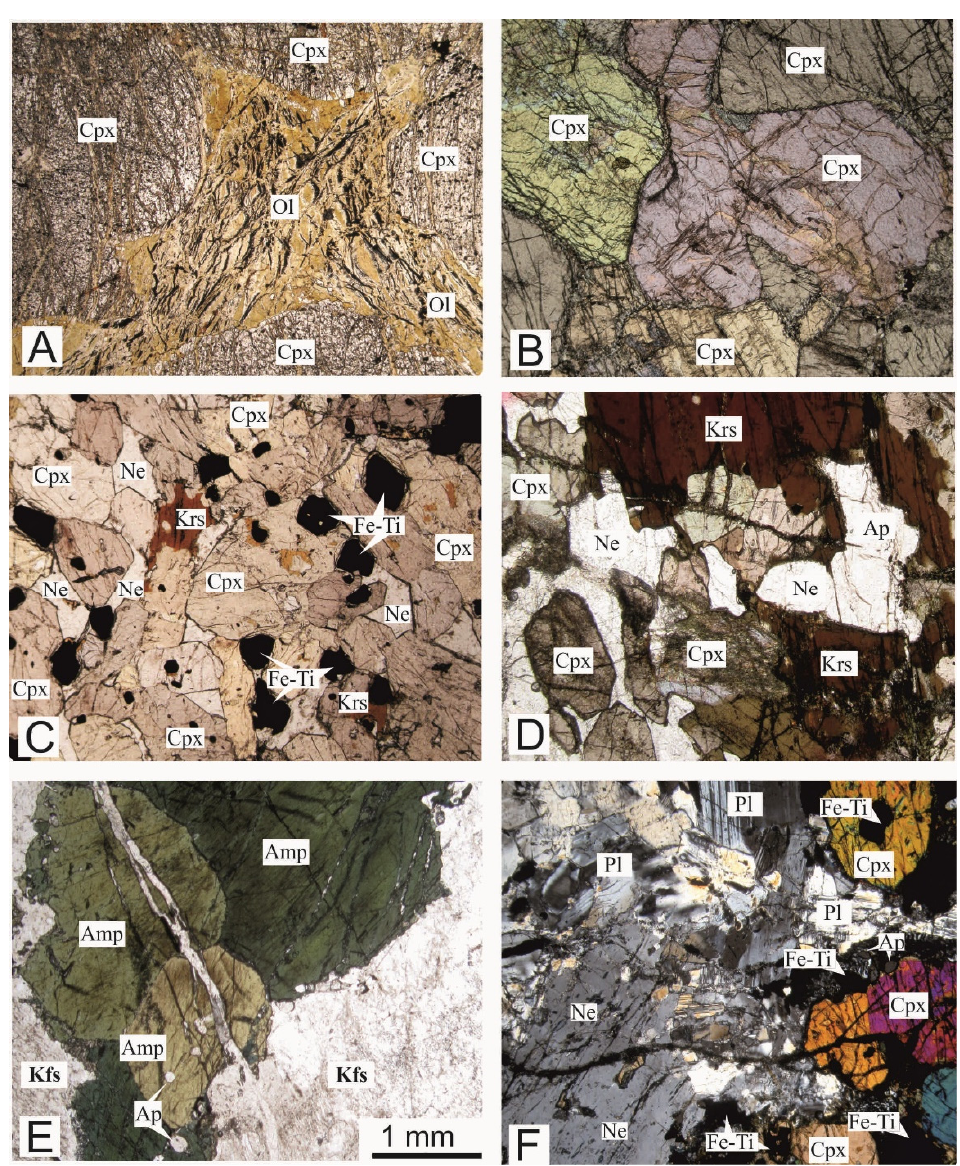
large (up to 5–6 mm) grains. Mafic minerals (<20 vol %) are represented by 2–3 mm grains and aggregates of 1–2 mm grains of pargasitic amphibole with dark green to light brown green pleochroism. Accessory minerals are represented by Fe-Ti oxides observed as scarce grains in amphiboles, F-apatite, and titanite.